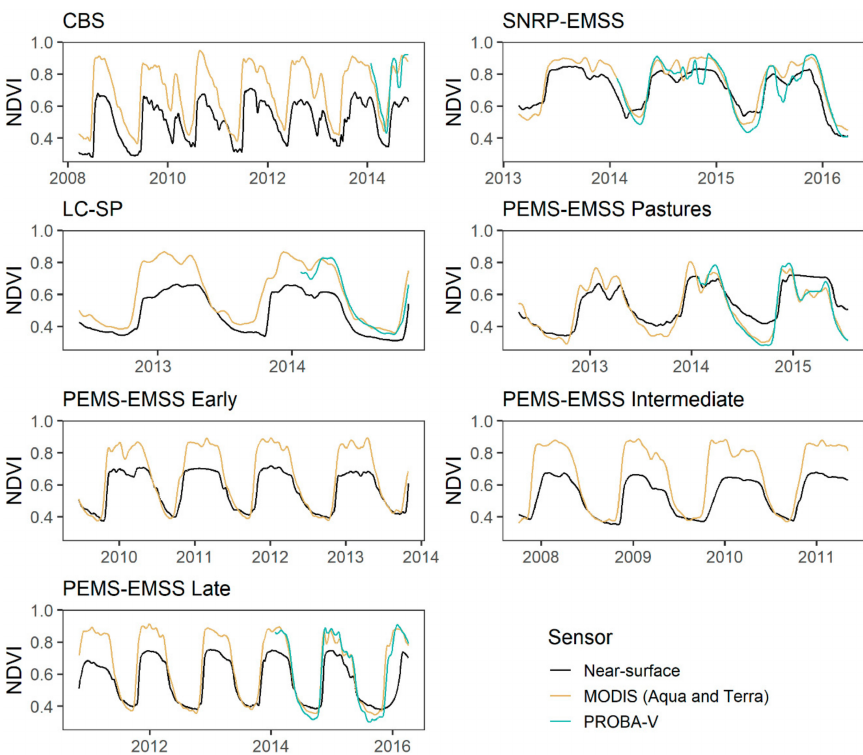
Figure 2. Time series of Normalized Di ff erence Vegetation Index (NDVI) derived from phenology towers, MODIS (Moderate Resolution Imaging Spectroradiometer), and PROBA-V (Project for On-Board Autonomy–Vegetation) observations at four di ff erent tropical dry forest locations. Observations at the Parque Estadual da Mata Seca (PEMS-EMSS) come from four sites with di ff erent successional